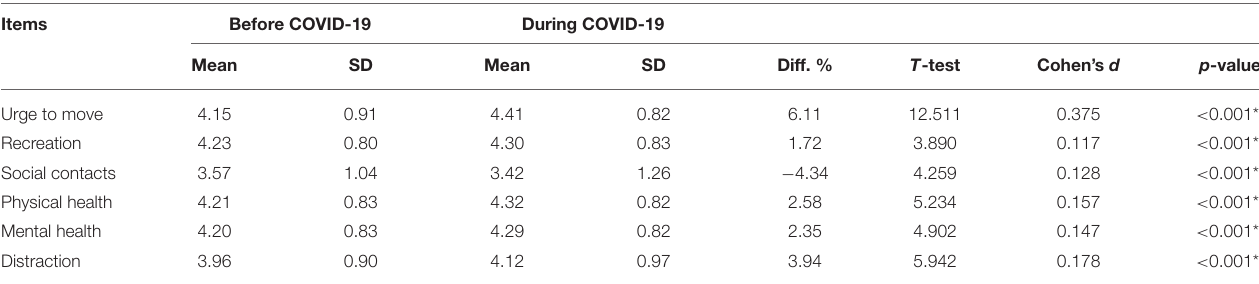
TABLE 3 | Reasons for being outdoors before and during the COVID-19 pandemic ( n = 1,115). Items Before COVID-19 During COVID-19 Mean SD Mean SD Diff. % Cohen’s d Urge to